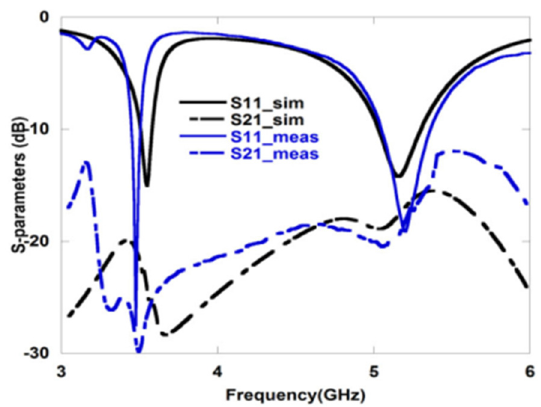
Figure 11. Simulated S − parameters for MIMO antenna [47].